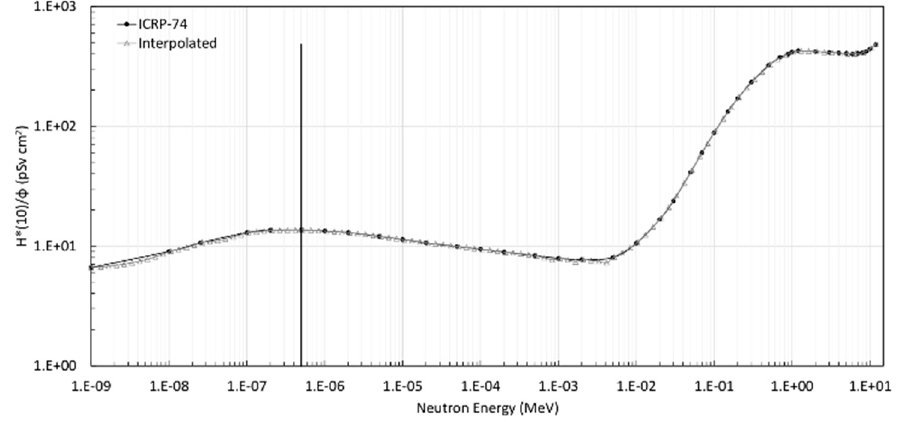
Figure 4. Flux ‐ to ‐ dose equivalent conversion coefficient on a log ‐ log scale reported in ICRP ‐ 74 [47] and the interpolated curve in the energy values of HOTNES spectrum. The vertical solid black line indicates the energy level of 0.5 eV.